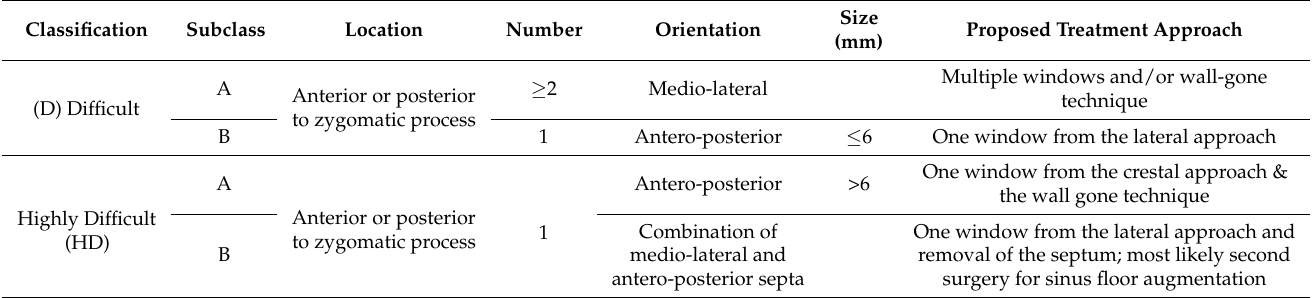
Table 3. Minor modification brought to Wen’s classification, with the combination of medio-lateral and antero-posterior septa in Highly Difficult (HD) group. In both classes (D-Difficult and HD-Highly Difficult) there are two subdivisions (A and B), which vary in different orientation of the septa and treatment options.